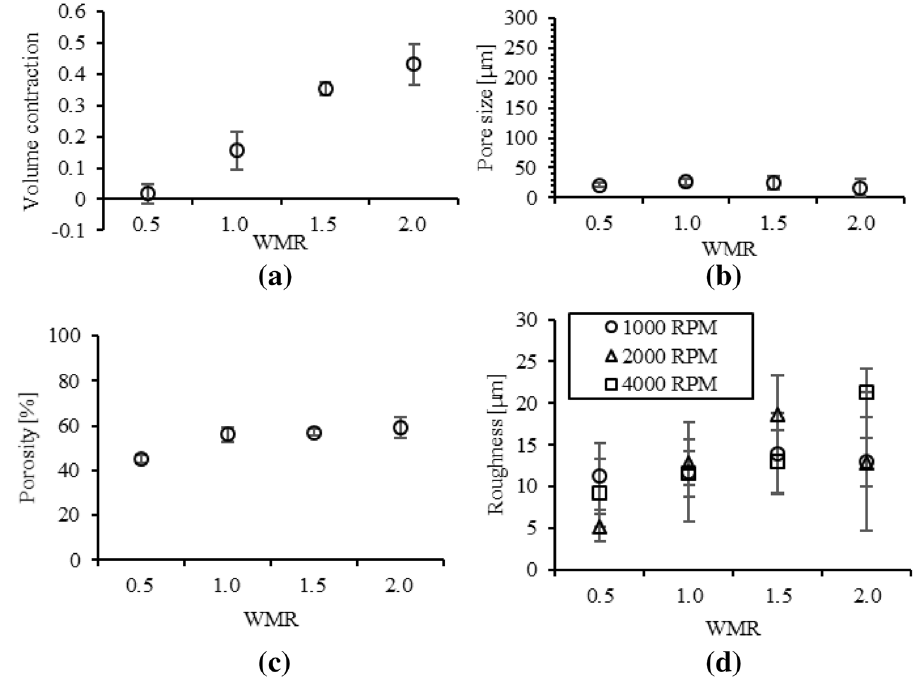
Figure 3. Properties of the present porous PDMS layer, fabricated at t e = 150 °C for varying WMR: ( a ) volumetric contraction; ( b ) pore size; ( c ) porosity; ( d ) surface roughness.